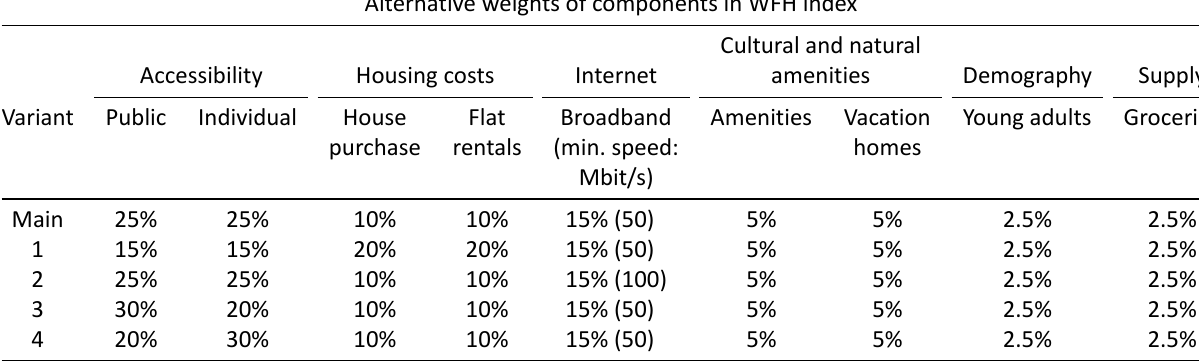
Table 2. Weights of WFH index variants in Figure 8.